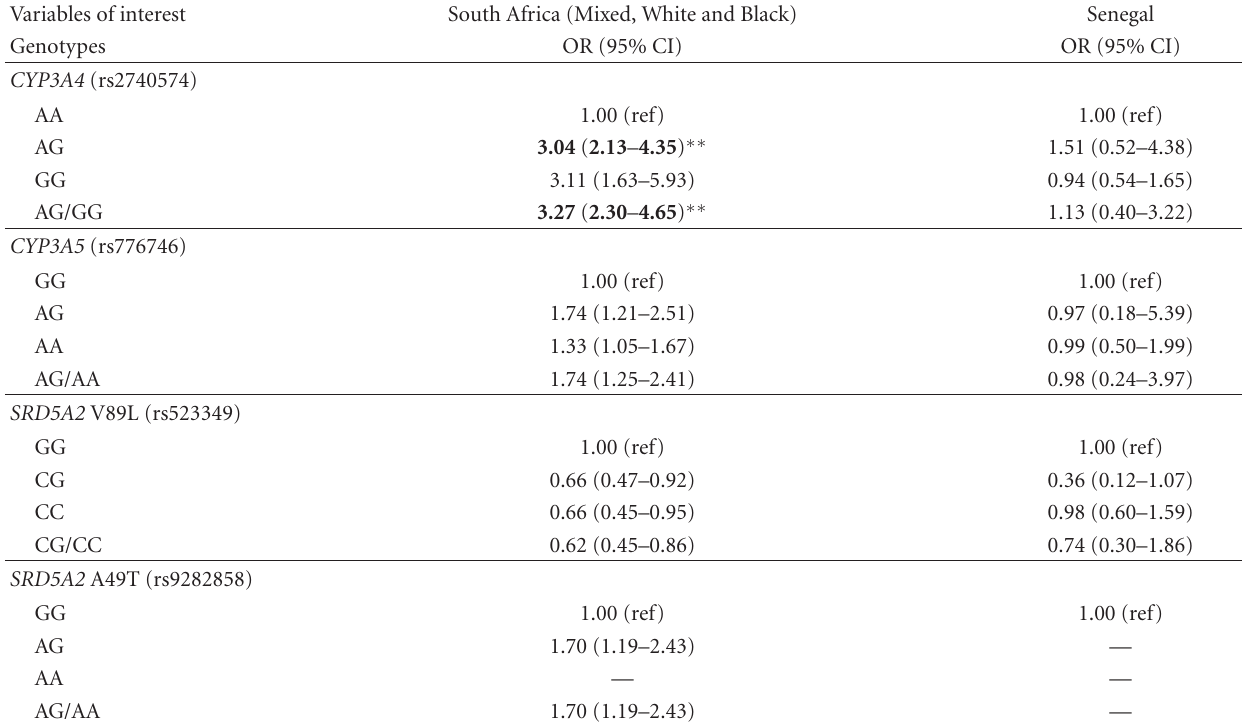
Table 4: Combined South African and Senegalese case-control genotype associations with prostate cancer (adjusted for age). Variables of